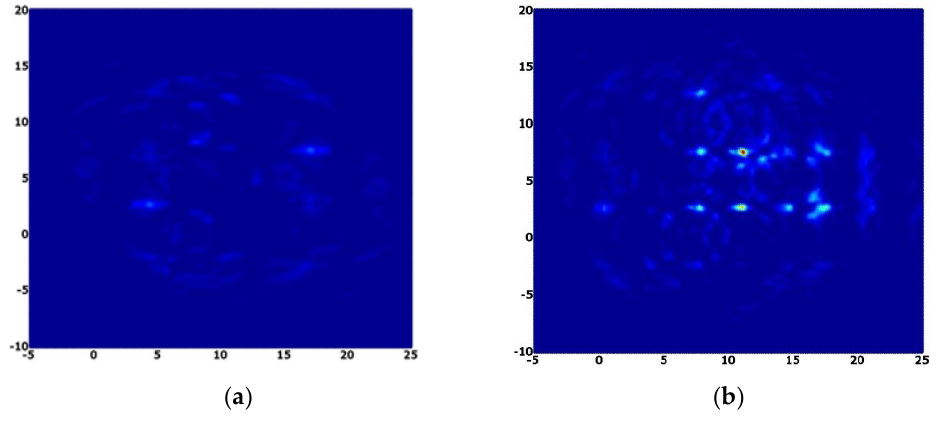
Figure 12. ( a ) Interpolated image and ( b ) averaged image.